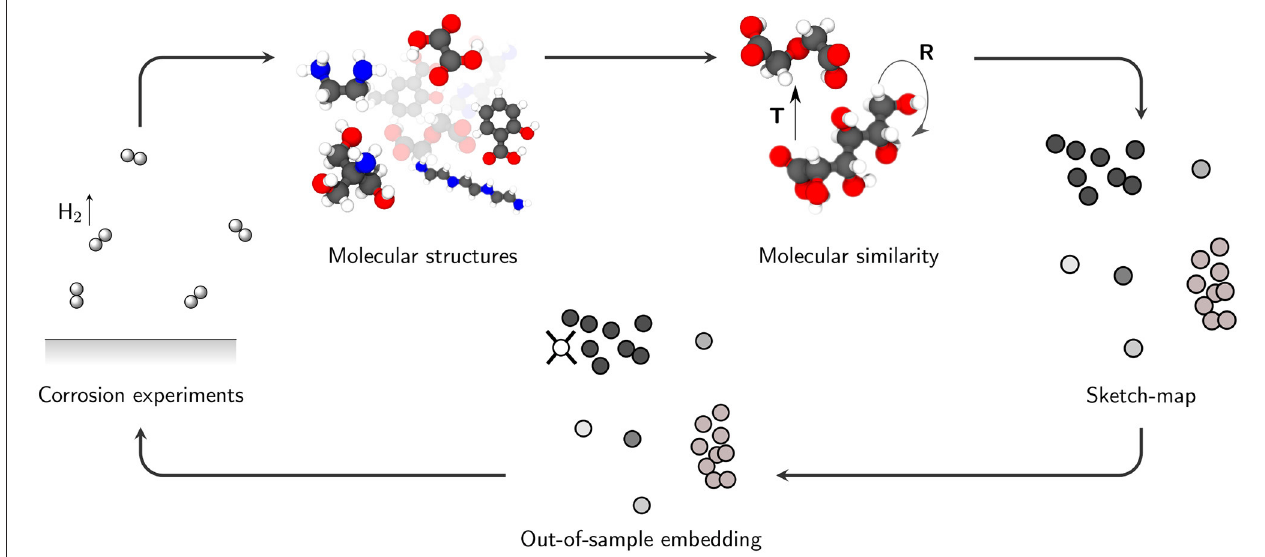
FIGURE 1 | The workflow diagram. Molecular structures from an inhibitor database (Lamaka et al., 2017) are used to generate a two-dimensional sketch-map. Inhibition efficiencies determined in the hydrogen evolution experiments, as well as data generated in DFT computations are used to investigate the property-structure relationship. Unknown structures can be projected into the sketch map to get a first indication on their potential inhibition efficiency. Potentially interesting structures can be then tested again in corrosion experiments to extend the inhibitor